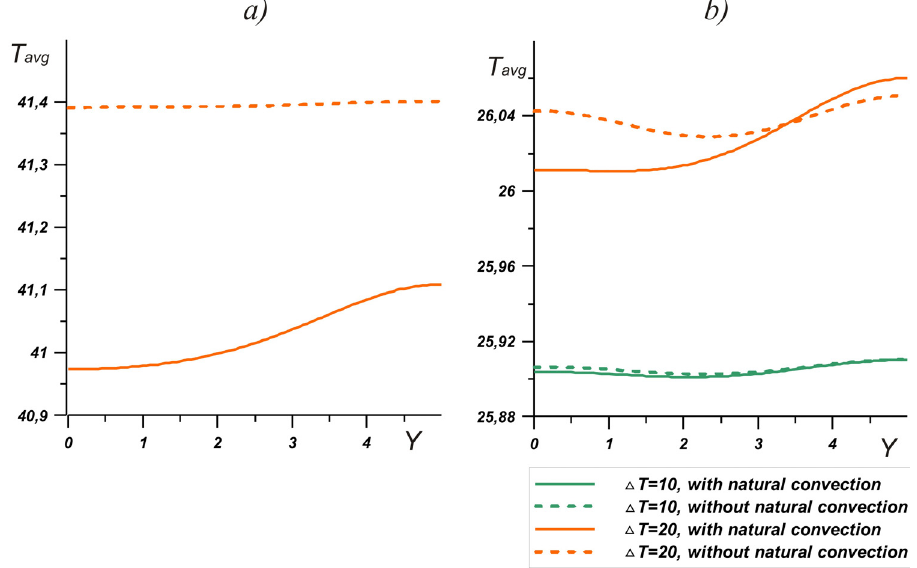
Figure 9. Temperature profiles on the left wall for ∆ T = 20° ( a ) and on the right wall for ∆ T = 10° and ∆ T = 20° ( b ) at L = 0.02m.